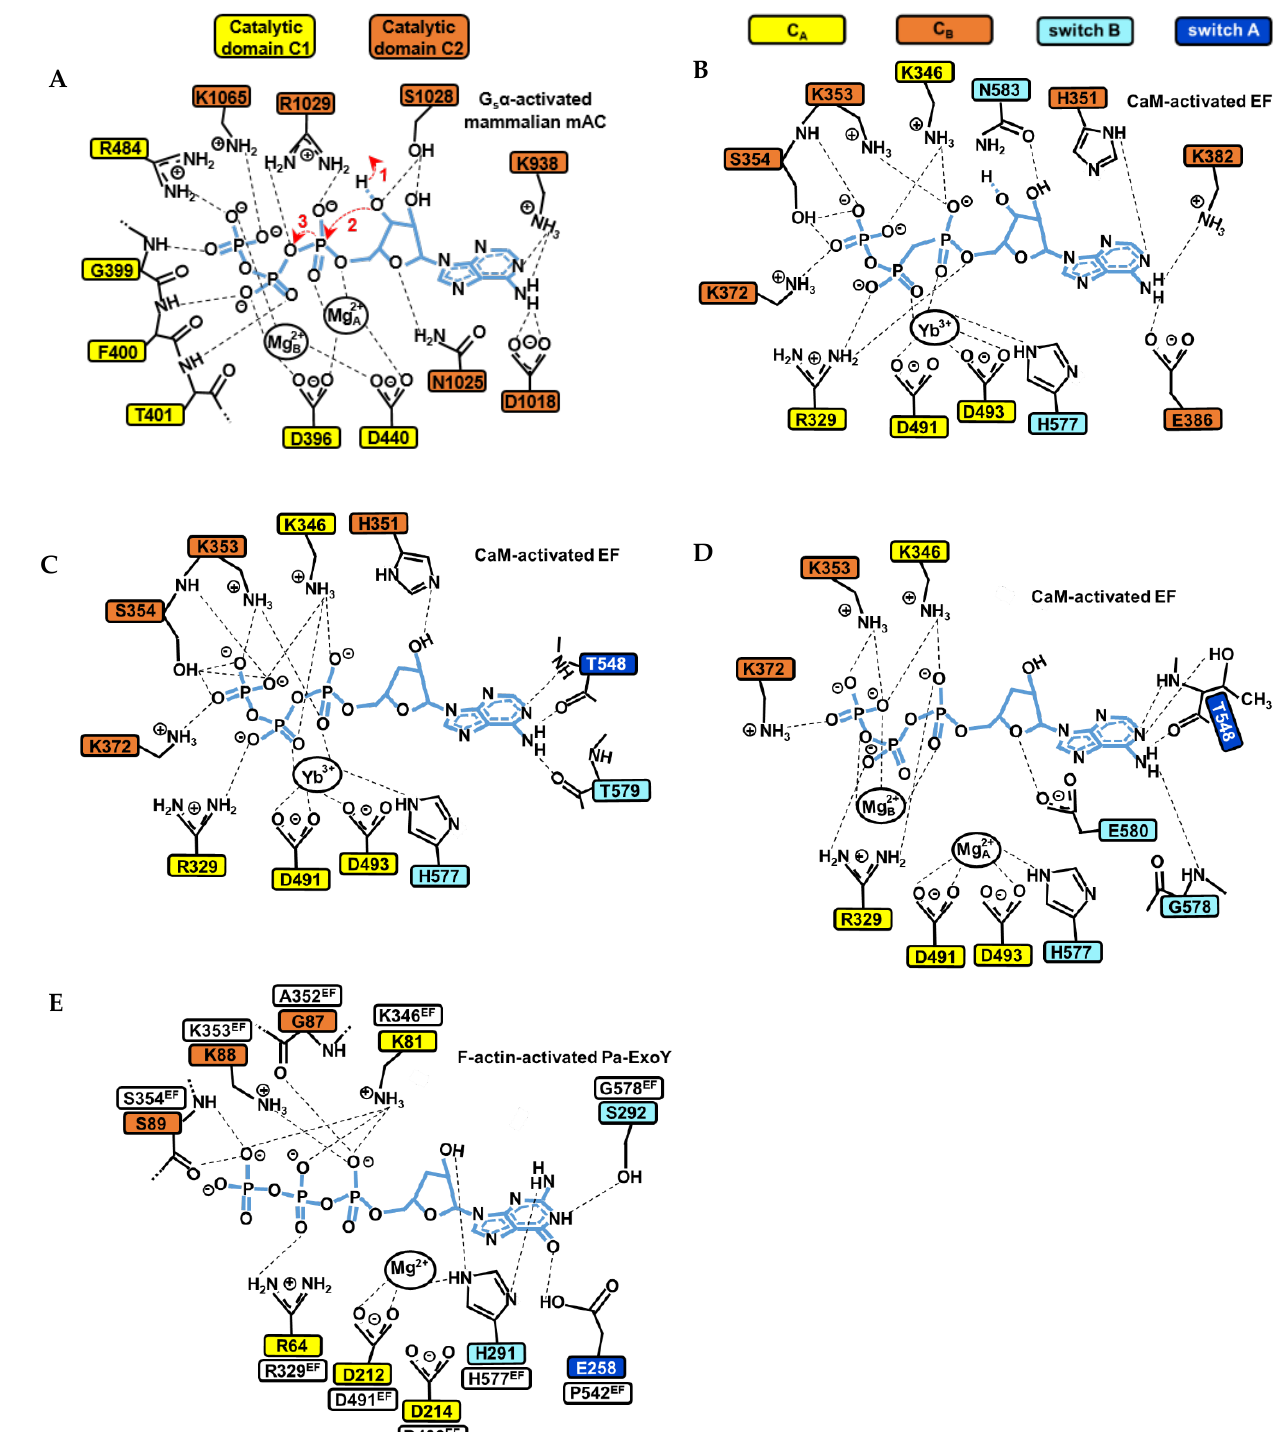
Figure 8. Structural model of the catalytic site of bacterial NC toxins and mammalian tm AC in the presence of ATP or GTP substrate analogues. ( A ) Simulated structural model of the catalytic site of the mammalian type V AC C1/type II AC C2 heterodimer in the presence of ATP based on the interactions seen with the non-cyclizable substrate analogue R P - ATPαS bound with two ion metals (PDB: 1CJK) [143]. The main steps 1, 2 and 3 of the cyclization reaction (to see text in Section 5.3) are indicated by red arrows. ( B – D ) The active site of CaM-activated EF structure with ( B ) the non-cyclizable ATP analogue AMPcPP and a single Yb 3+ metal ion in PDB: 1S26 [31]. ( C ) The non-cyclizable ATP analogue 3′ dATP and a single Yb 3+ metal ion in PDB: 1K90 [37]. ( D ) 3′ dATP and two Mg 2+ metal ions in PDB: 1XFV [137]. ( E ) The active site of F- actin-activated Pa -ExoY with the non-cyclizable